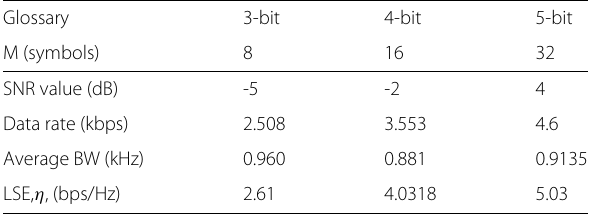
Table 6 Spectral efficiency of PBCCS at P e = 10 − 5 bit error probability